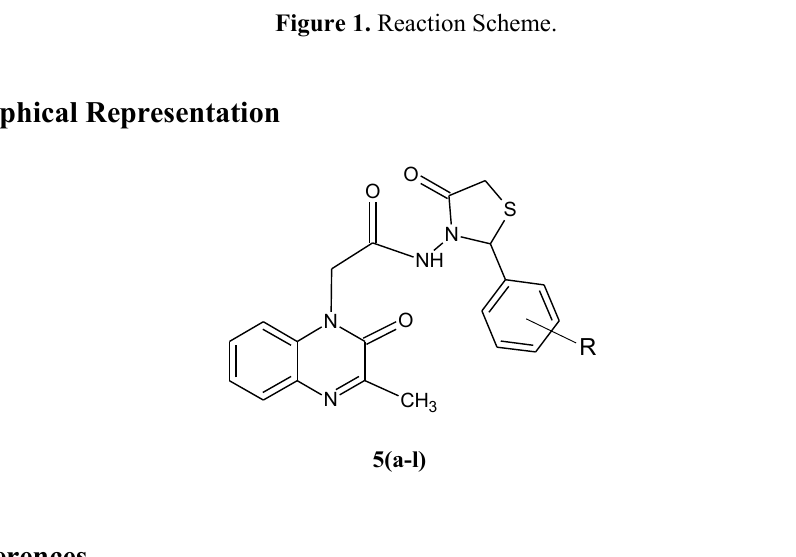
Figure 1. Reaction